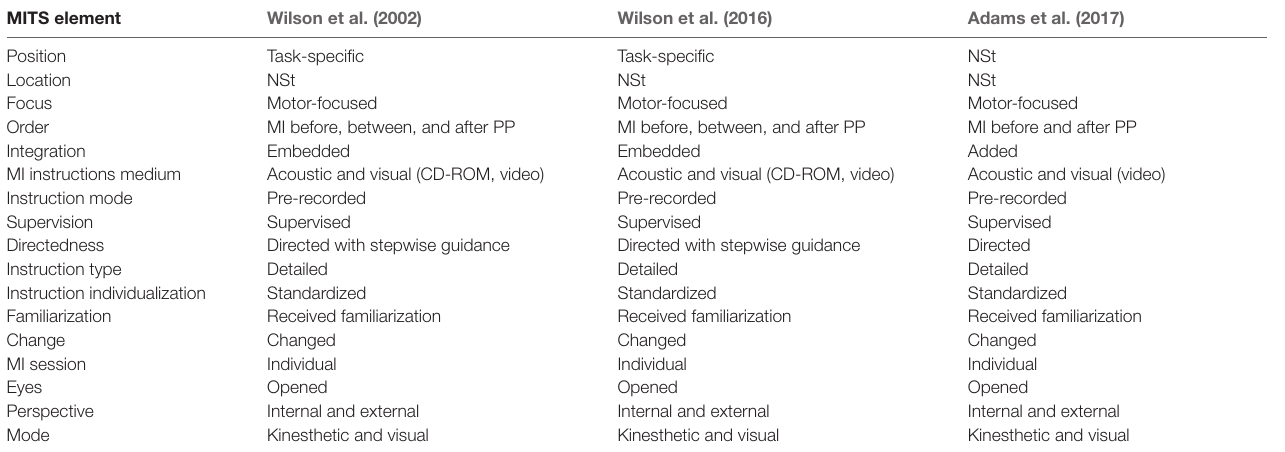
TABLE 2 | Overview of extracted motor imagery training sessions (MITS)